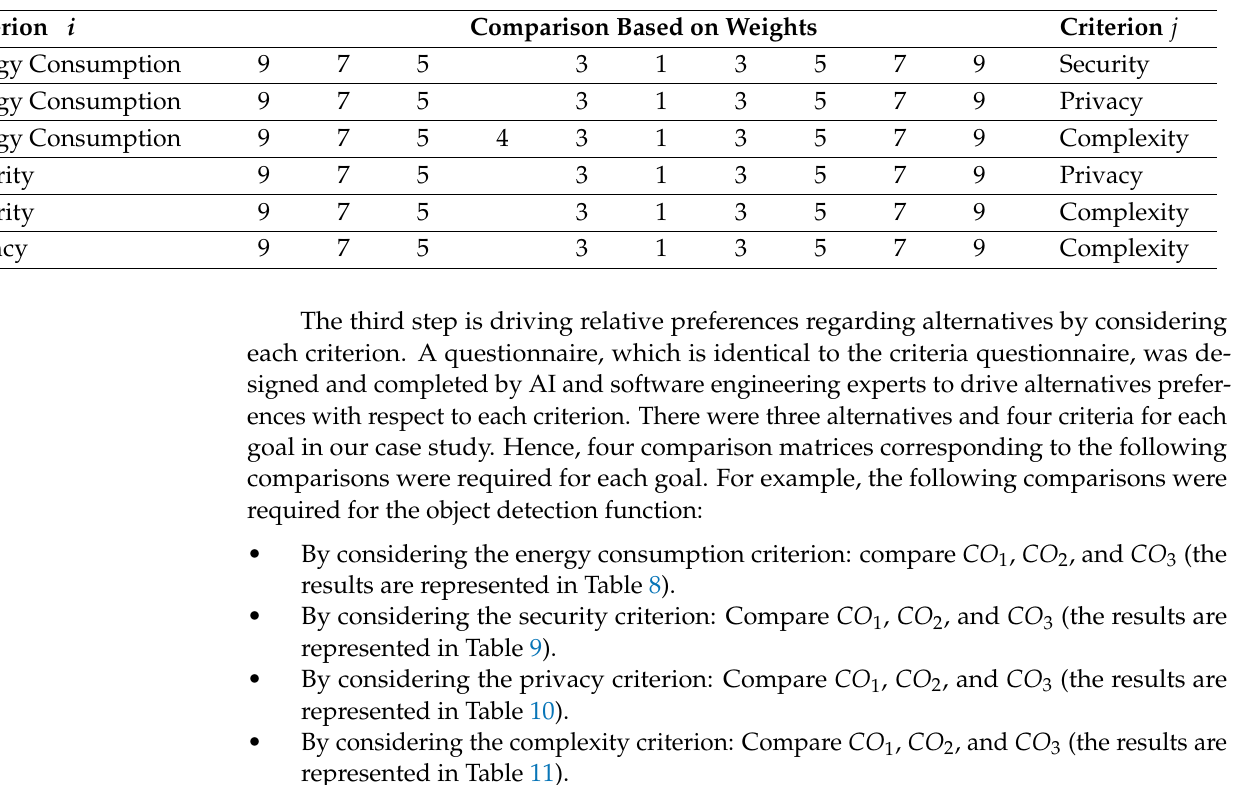
Table 7. An example of a complete questionnaire for object detection.